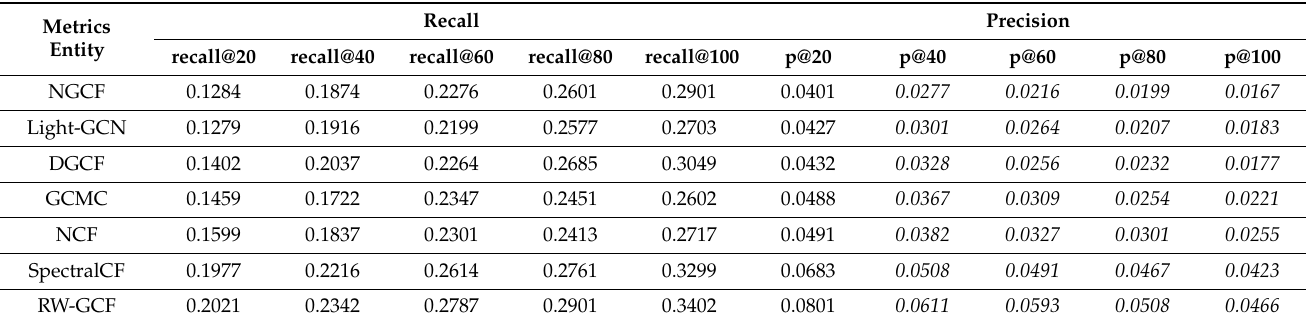
Table 3. Model Comparison: